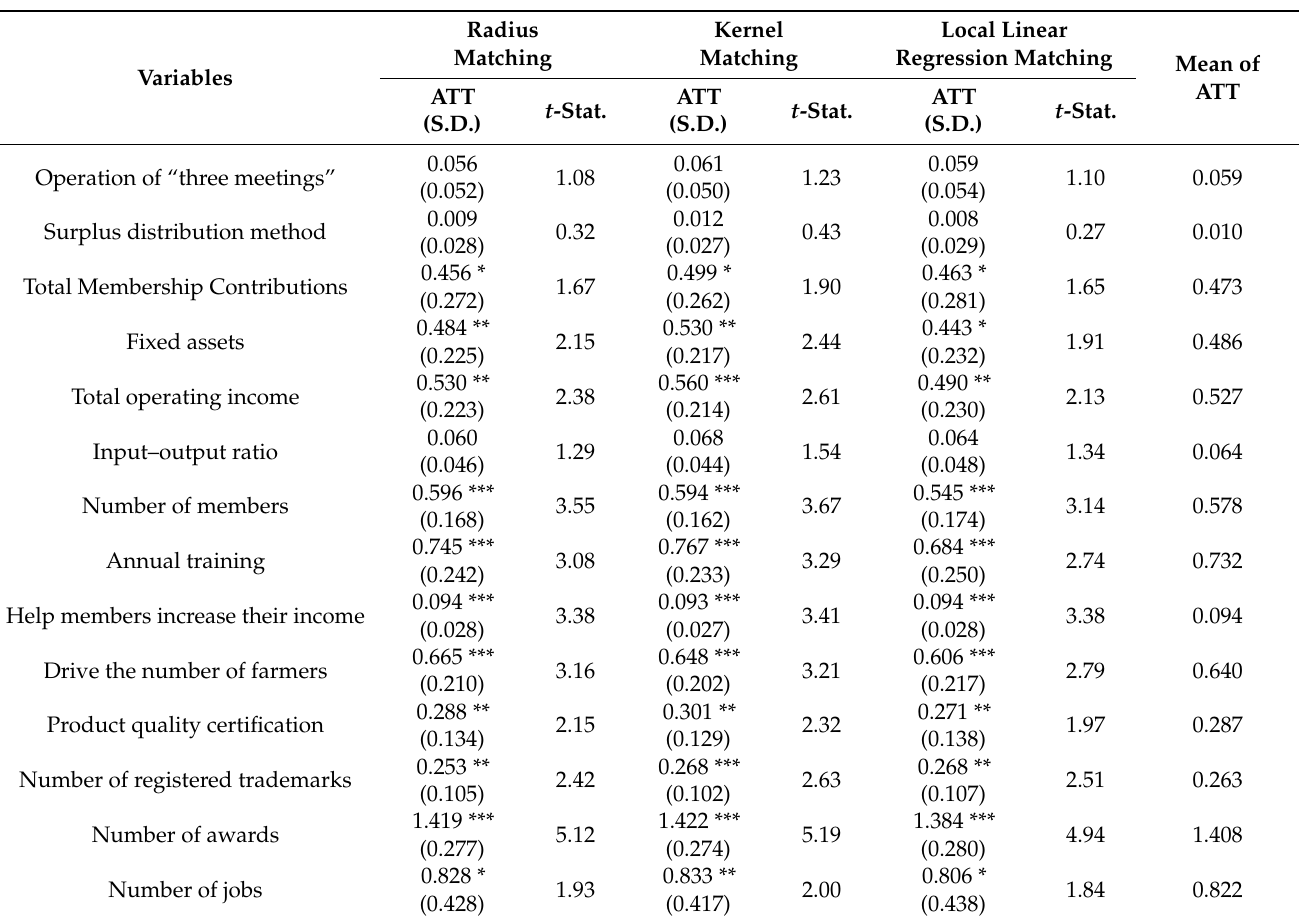
Table 7. Potential policy effect results of demonstration